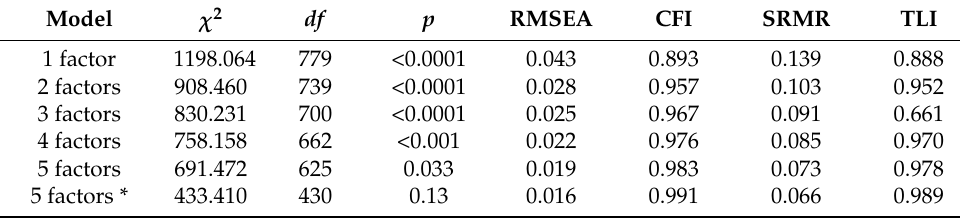
Table 3. Model Fit Indices Comparison.